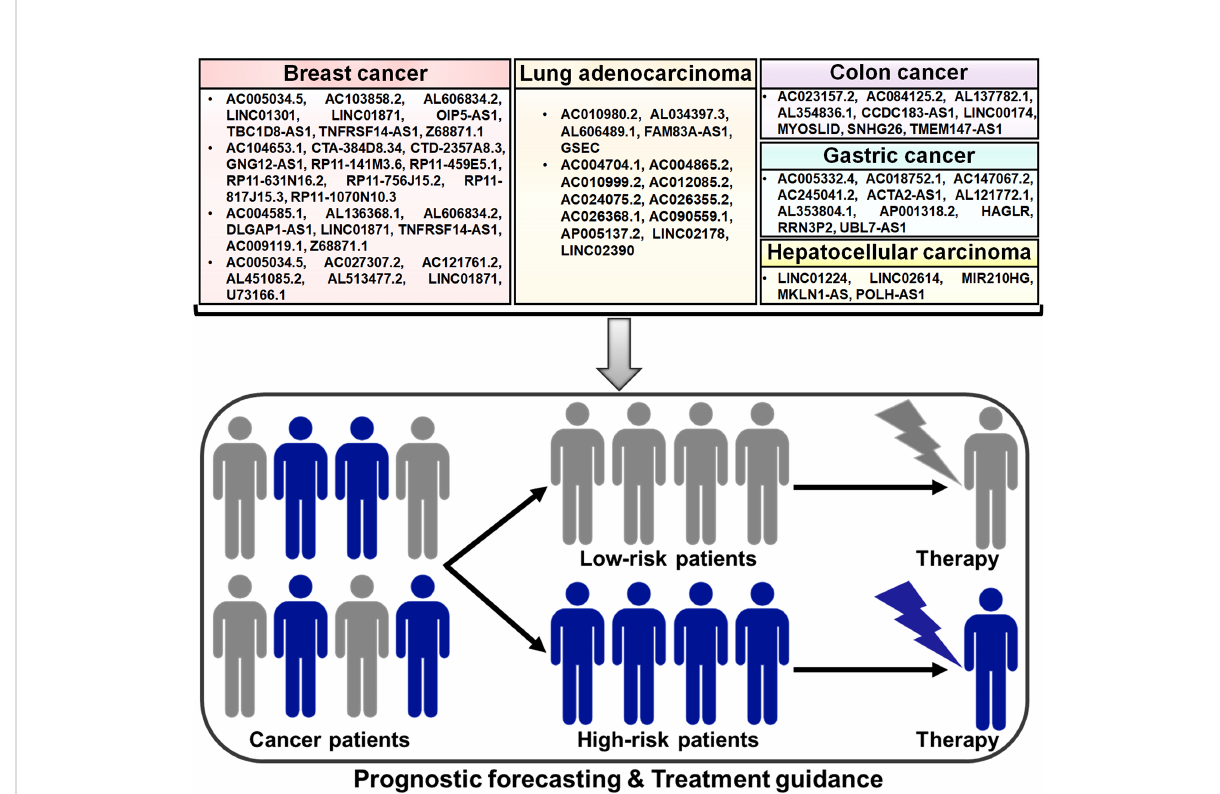
FIGURE 3 Potential clinical application of pyroptosis-related lncRNAs in cancer. Some prognostic models based on pyroptosis-related lncRNAs have been established, which can be useful in predicting the risk of poor clinical outcomes in patients with different cancers, including breast cancer, lung adenocarcinoma and gastrointestinal tumors. These pyroptosis-related lncRNA prognostic models may be a promising tool for assessing therapeutic response in cancer patients and thus offer helpful guidance for personalized treatment of